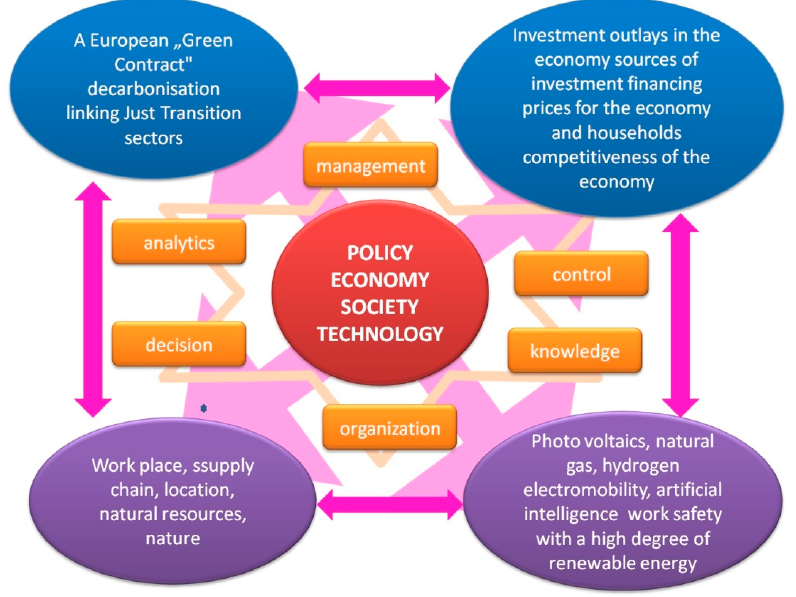
Figure 1. Dimensions and determinants of the energy transformation in Poland [9–11].